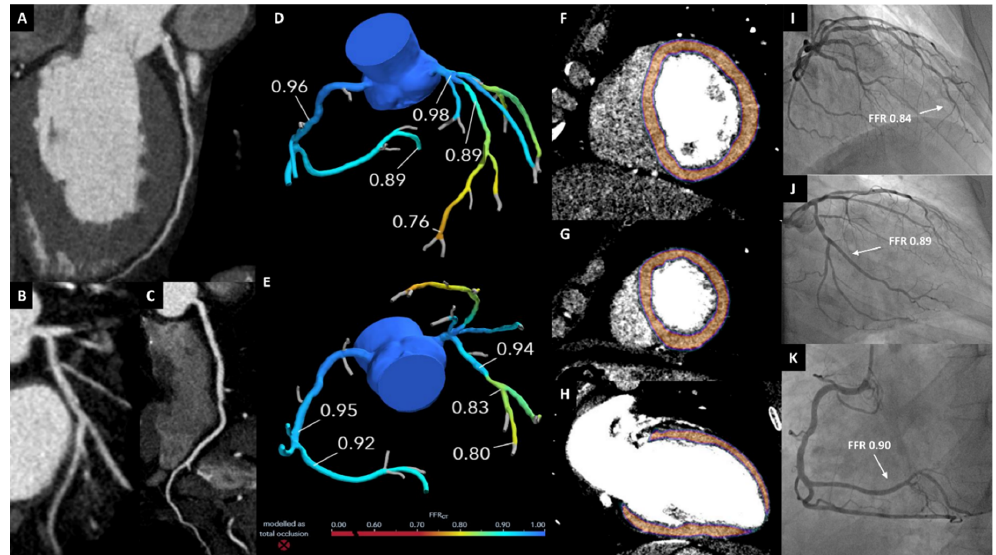
Figure 9. Clinical Case. A 54 y / o male with hypertension, dyslipidaemia and recent onset of atypical chest pain. Panels ( A – C ): cCTA showing significant stenosis in the proximal LAD ( A ), moderate stenosis in the proximal LCx ( B ), and moderate stenosis in the mid RCA ( C ). Panels ( D , E ): FFR CT showing grey-zone values in the apical LAD, negative values in the RCA and LCx. Panels ( F – H ): Static Stress-CTP with short axis views ( F , G ) and 2-chamber long axis view ( H ) showing absence of perfusion defects. Panels ( I – K ): ICA showing moderate stenoses in the proximal LAD ( I ) and LCx ( J ), and mild stenosis in the mid RCA ( K ), all with negative FFR values. cCTA: coronary computed tomography angiography; LAD: left anterior descending; LCx: left circumflex; RCA: right coronary artery; FFR CT : computed tomography-derived fractional flow reserve; Stress-CTP: stress computed tomography perfusion; ICA: invasive coronary angiography; FFR: fractional flow reserve.